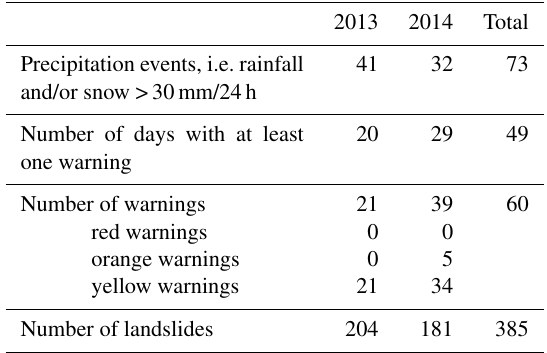
Table 3. Significant rainfall, number of days with at least one warn- ing, and number of warnings and landslides in the period 2013–